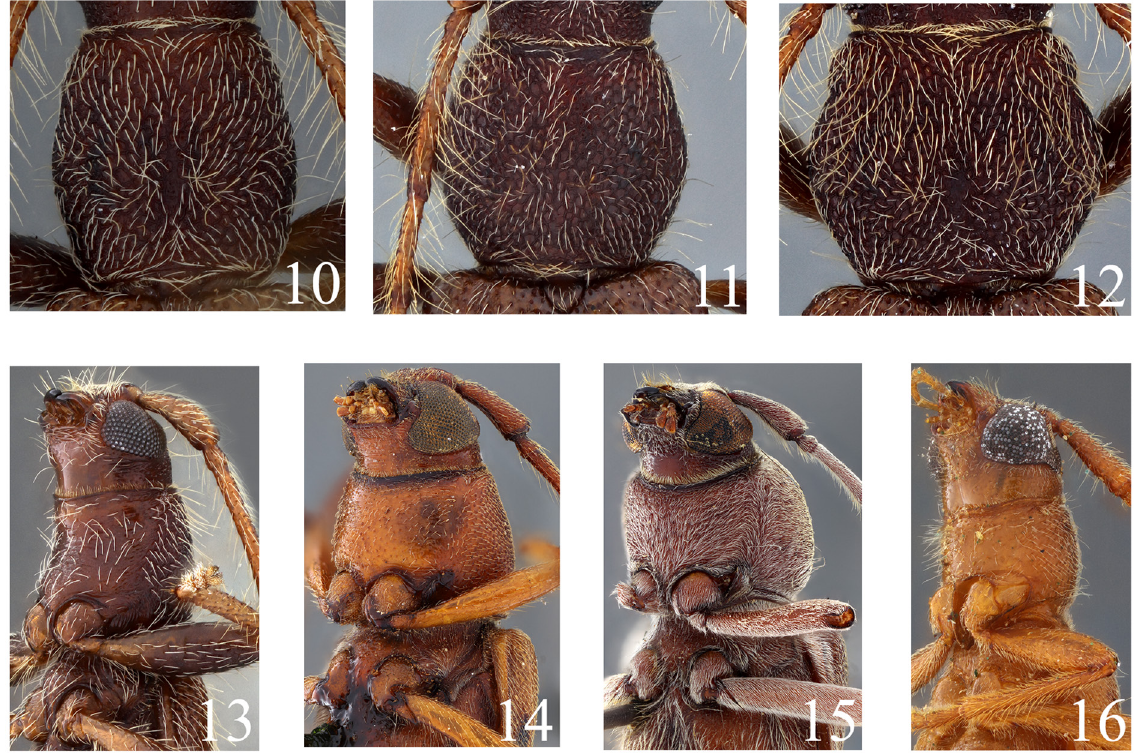
Figs 10–16. 10–12 . Details of pronotum of Ysachron pilosus gen. et sp. nov. 10 . Holotype, ♂ (MPUJ_ ENT 0071150). 11 . Paratype, ♀ (MPUJ_ENT 0071152). 12 . Paratype, ♀ (MZSP). 13–16 .